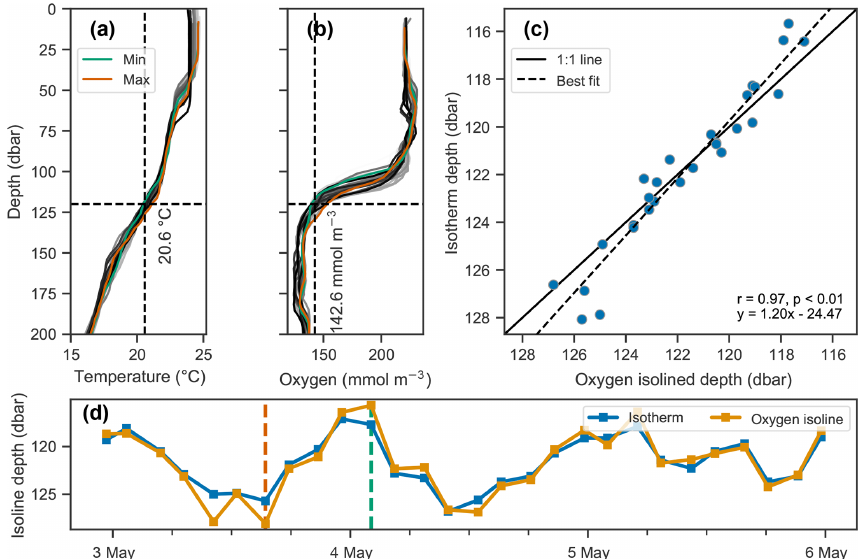
Figure 7. Covariation of isotherm and iso-concentration depths. (a–b) Profiles of temperature and dissolved oxygen, where the profiles with the minimum and maximum depths of the 20.6 ◦ C isotherm and 142.6mmol O 2 m − 3 iso-concentration are shown in green and orange respectively, and all other profiles are shown on a gray color scale indicative of time, with lighter shades indicating older and darker shades more recent measurements. (c–d) Depths of the isotherm and iso-concentration plotted against each other in (c) and as a time series in (d) , showing their covariation.